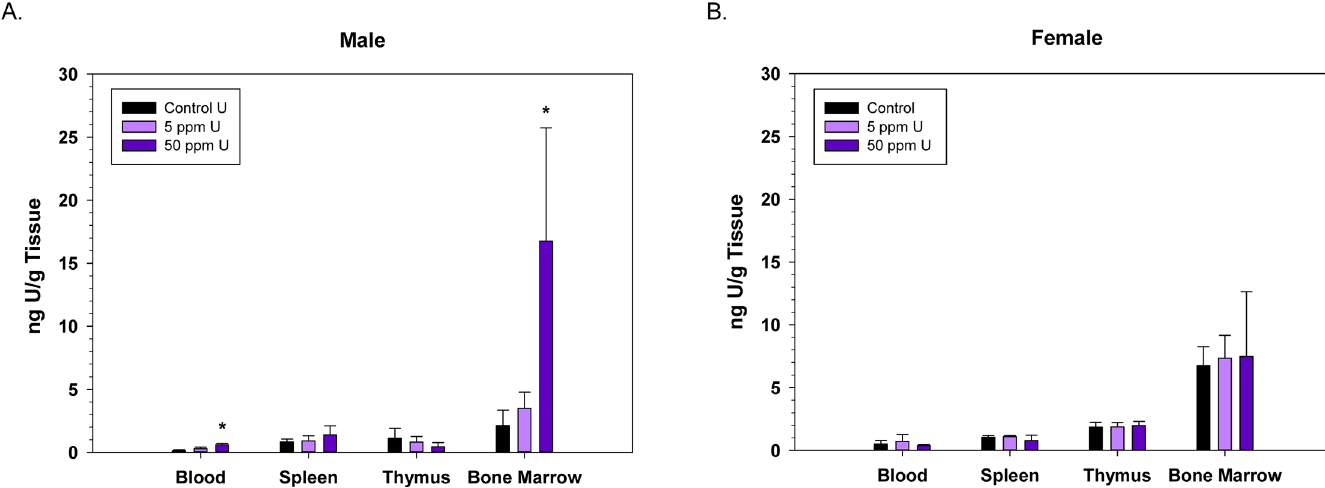
Fig 1. Uranium is detected in the blood and bone marrow of male mice following a 60-d oral exposure. Uranium concentrations in single cell suspensions (bone marrow, spleen, and thymus) and whole blood were analyzed by ICP/MS, following an oral 60-d exposure to uranyl acetate. Graph indicates mean g uranium/g of tissue +/- S.D. of mean for each cell type in male (A) and female (B) mice. n = 6 or 7 group. (cid:3) p < 0 . 05 ;One-Way ANOVA or Kruskal Wallis ANOVA, as